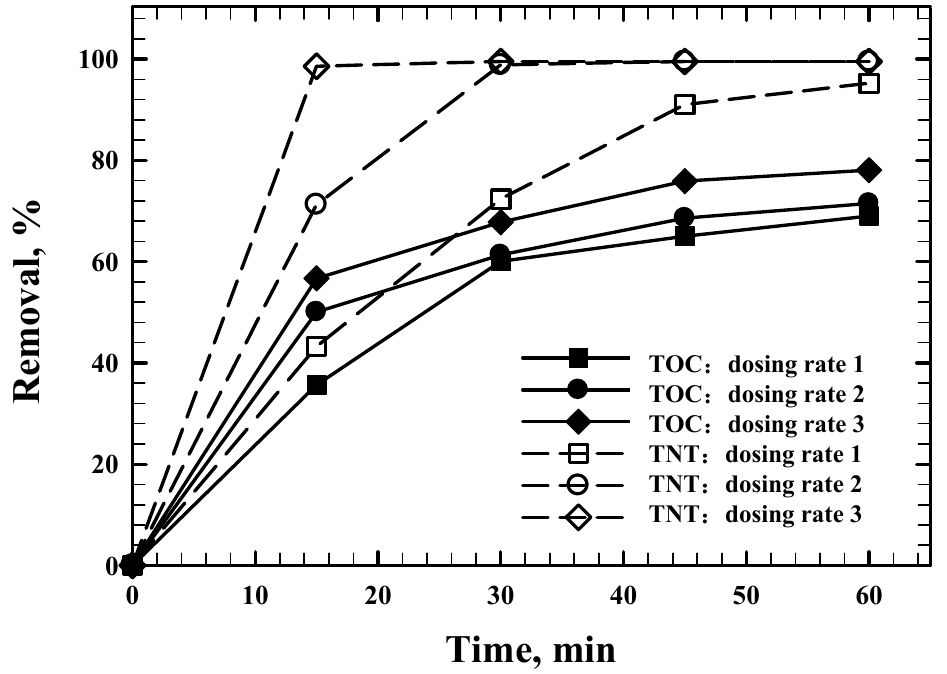
Figure 6. Effect of dosing rate on TNT and TOC removal. Experimental condition: (TNT) 0 = 30 mg/L, (NaCl) = 10 − 2 M, Initial pH = 3.0 ± 0.1, Temperature = 25 °C, US intensity = 8571W/m 3 , Reaction time = 60 min, Dosing rate 1: (H 2 O 2 ) = 2.5 × 10 − 6 mol/min, (Fe 2+ ) = 2.5 × 10 − 7 mol/min, Dosing rate 2: (H 2 O 2 ) = 5.0 × 10 − 6 mol/min, (Fe 2+ ) = 5.0 × 10 − 7 mol/min, Dosing rate 3: (H 2 O 2 ) = 7.5 × 10 − 6 mol/min, (Fe 2+ ) = 7.5 × 10 − 7 mol/min.